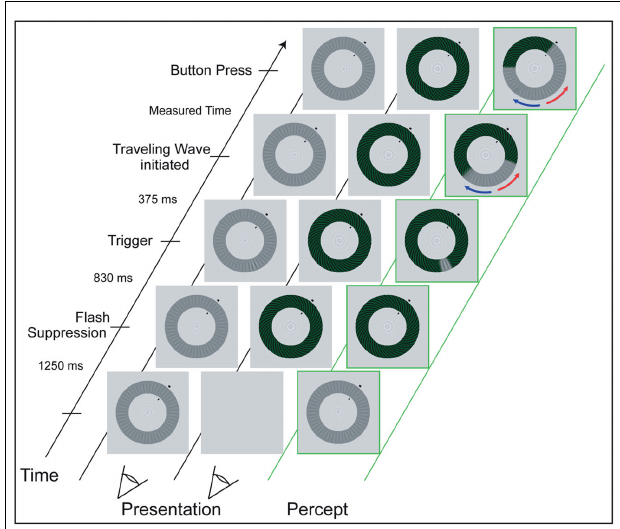
FIGURE 2 | Experimental procedure of the psychometric measurements (see text for a detailed description). While maintaining fixation on the small, central bull’s eye figure, participants monitored the perceptual wave that traveled along the shorter section between trigger location and arrival point (red arrow).The two columns to the left show the dissimilar images that are presented monocularly, while the green right column illustrates the resulting